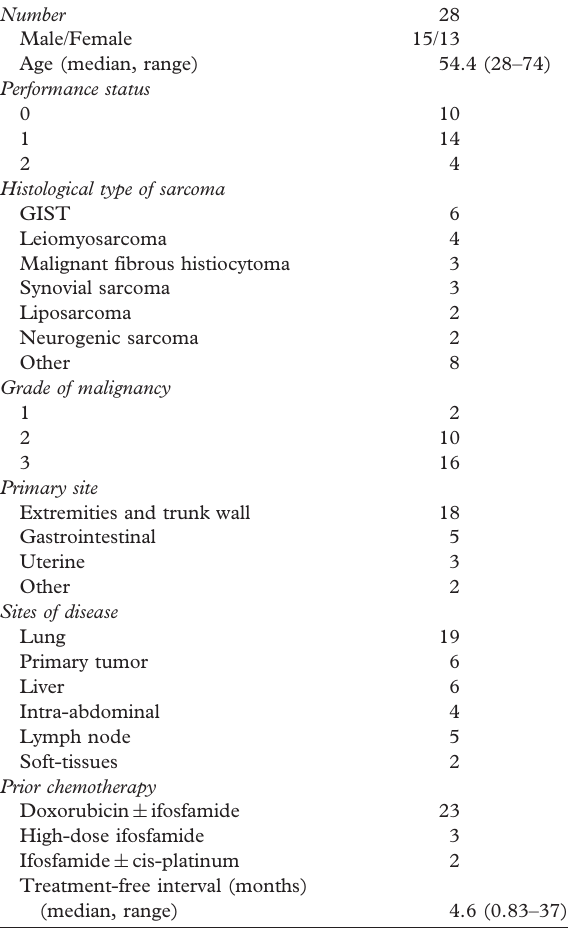
Table I. Patient characteristics. Table II. Maximum grade of toxicity observed per patient.